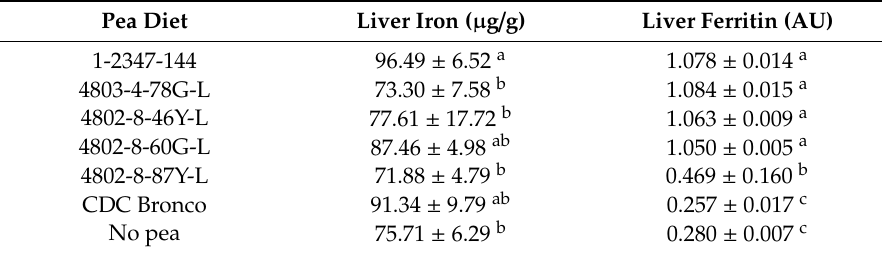
Table 9. Hepatic iron and ferritin protein concentrations 1 .